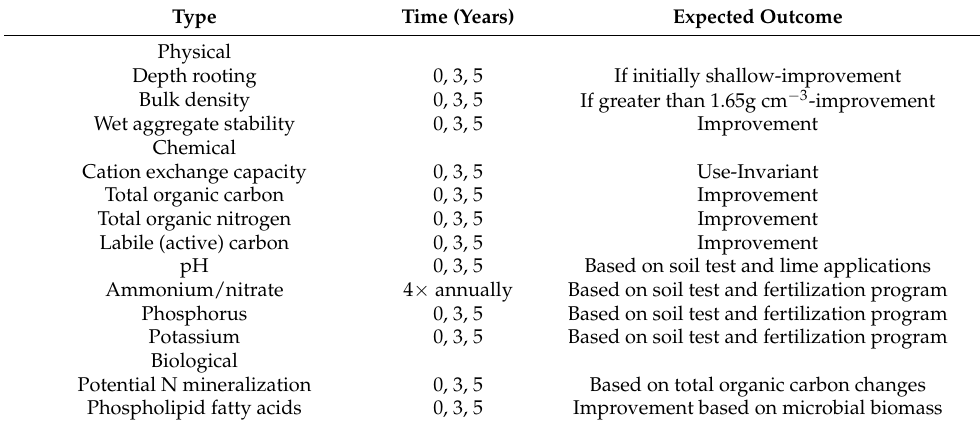
Table 3. Minimum set of soil indicators and their usage to assess grazing management across a five-year interval for small acreage cow-calf